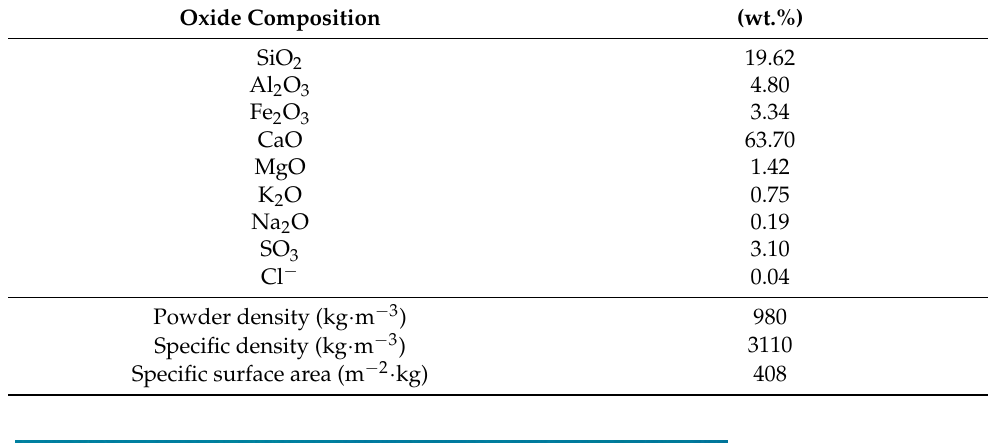
Table 1. Oxide composition and material characteristics of OPC.